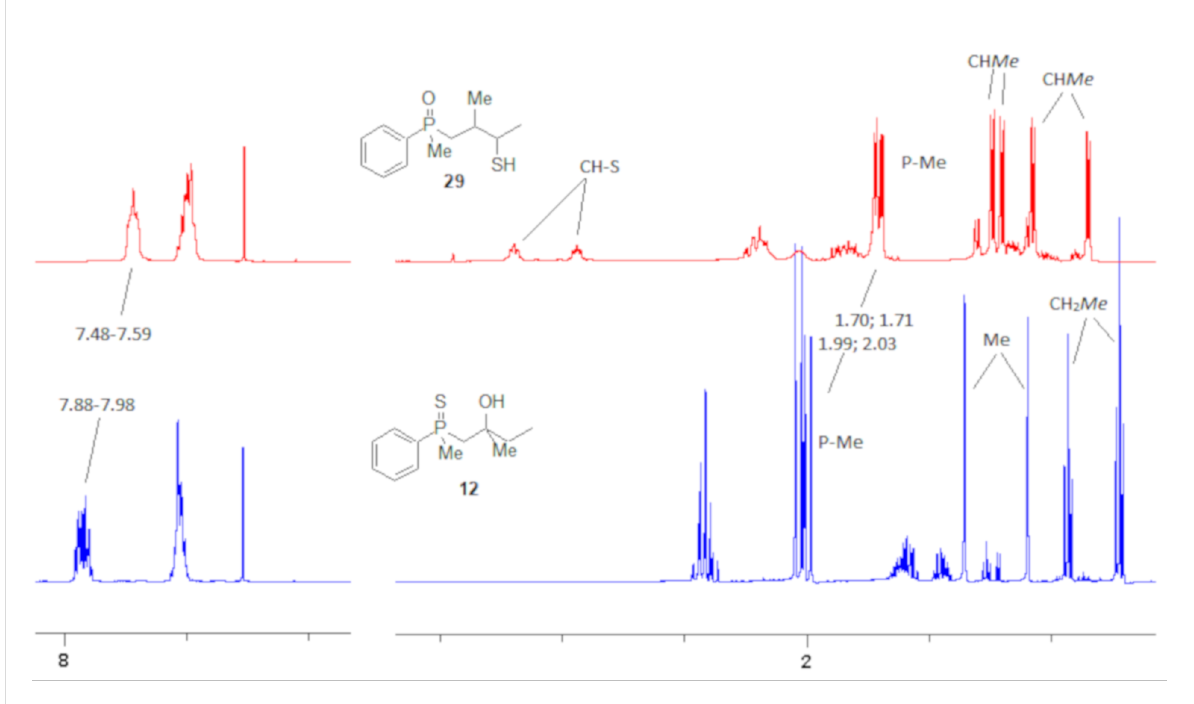
Figure 1: 1 H NMR spectra of compounds 12 and 29